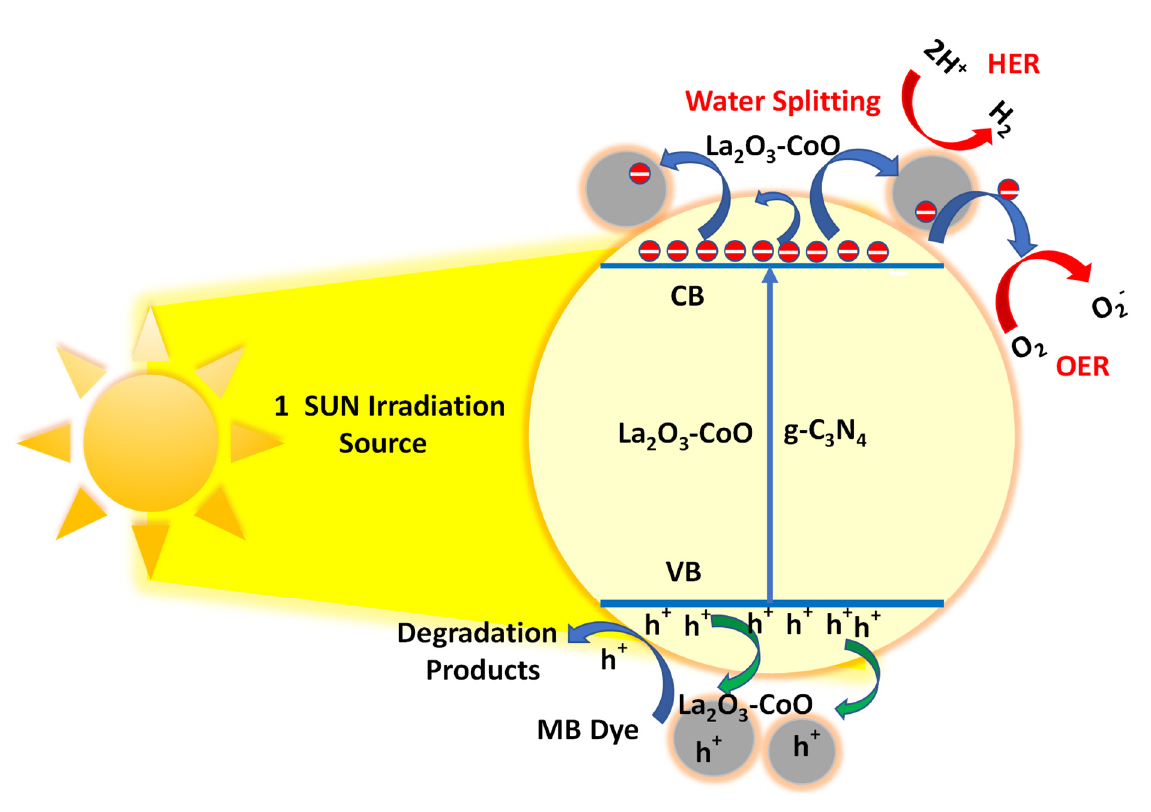
Figure 8. Pictorial illustration of a charge-transfer mechanism for photoelectrochemical water- splitting and MB photodegradation studies performed under 1 sun visible light.